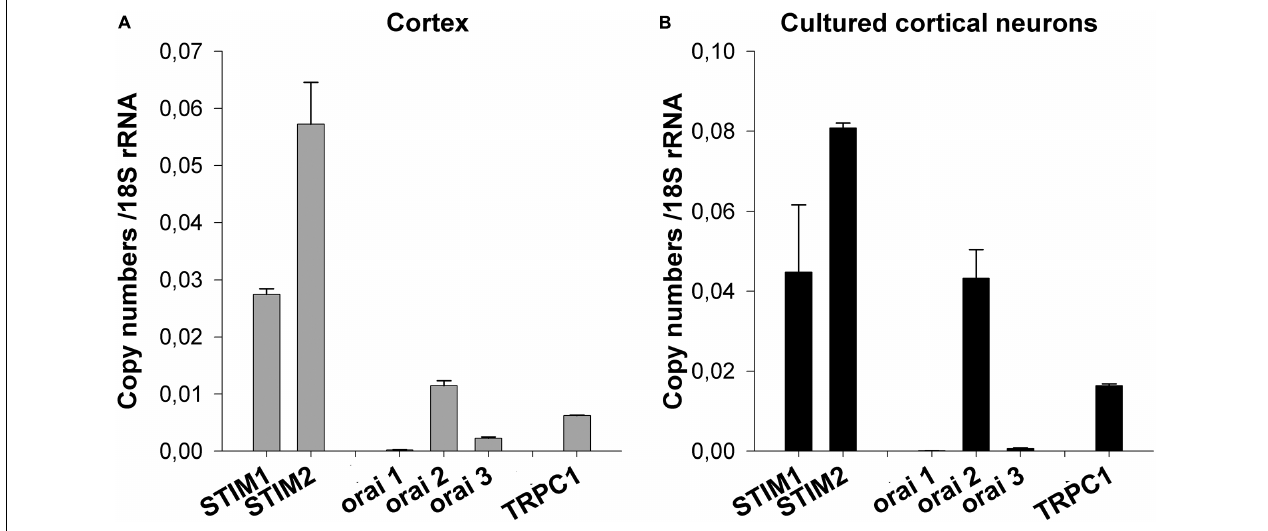
FIGURE 1 | Expression profile of STIM, Orai, and TRPC1 mRNAs. mRNAs were extracted from E13 cortices and from cultured cortical neurons kept in vitro for 8 days. They were analyzed by quantitative real-time RT-PCR. The mRNA expression levels of STIM1, STIM2, Orai1, Orai2, Orai3, and TRPC1 are compared to 18S rRNA. Mean ± SEM of experiments conducted in triplicate. Profile of mRNA expression in total E13 brain cortices (A) and in dissociated E13 cultured neurons (B) .